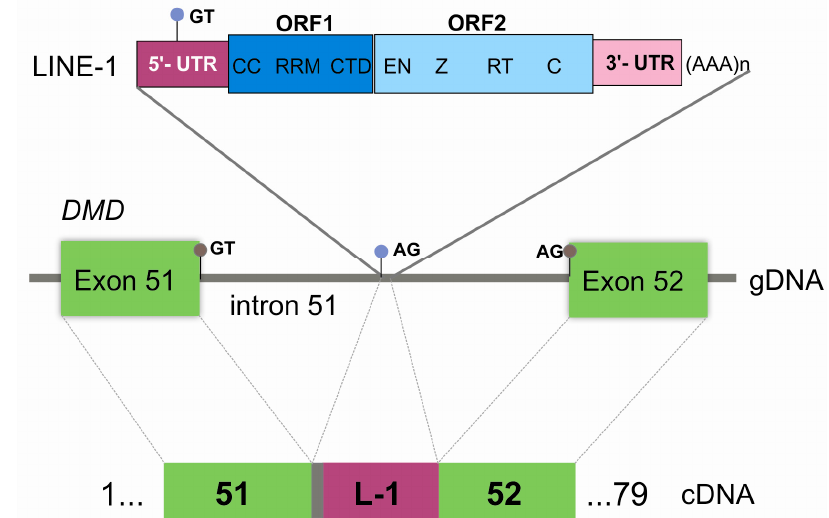
Figure 4. Graphical representation of the pathogenic LINE-1 insertion. At the genomic level (gDNA), the integration site is located in intron 51 of DMD . LINE-1 is displayed showing its characteristic